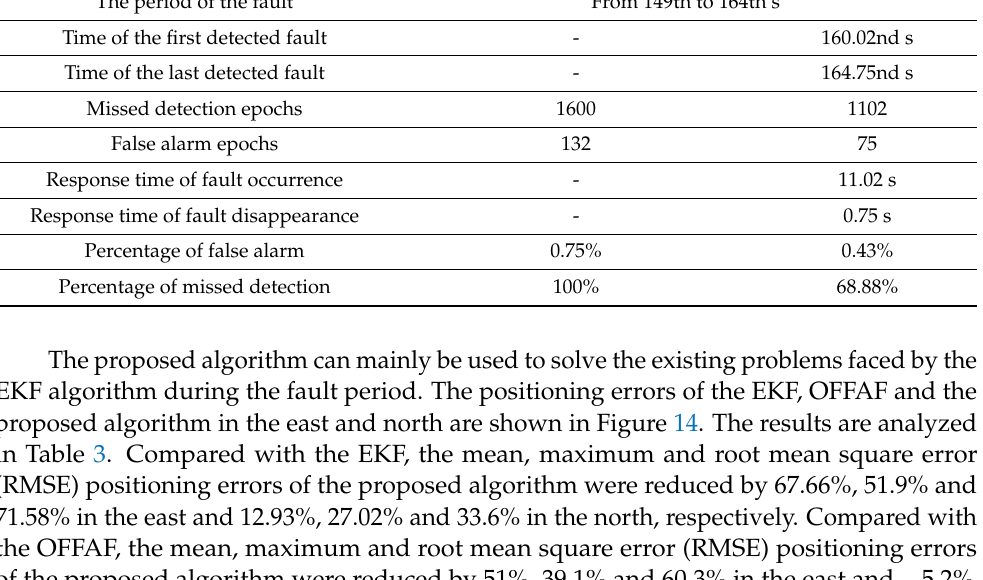
Table 2. The fault detection performance of the chi-square test and the proposed algorithm. The Residual Chi-Square Test Proposed Algorithm